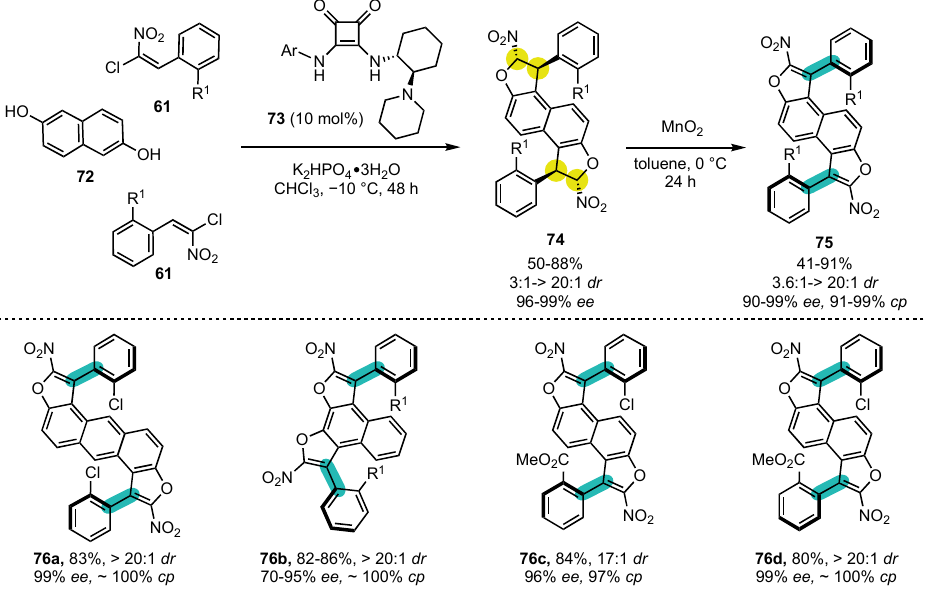
Scheme 19. Bidirectional synthesis of bis-benzofuran atropisomers with two distal stereogenic axes.